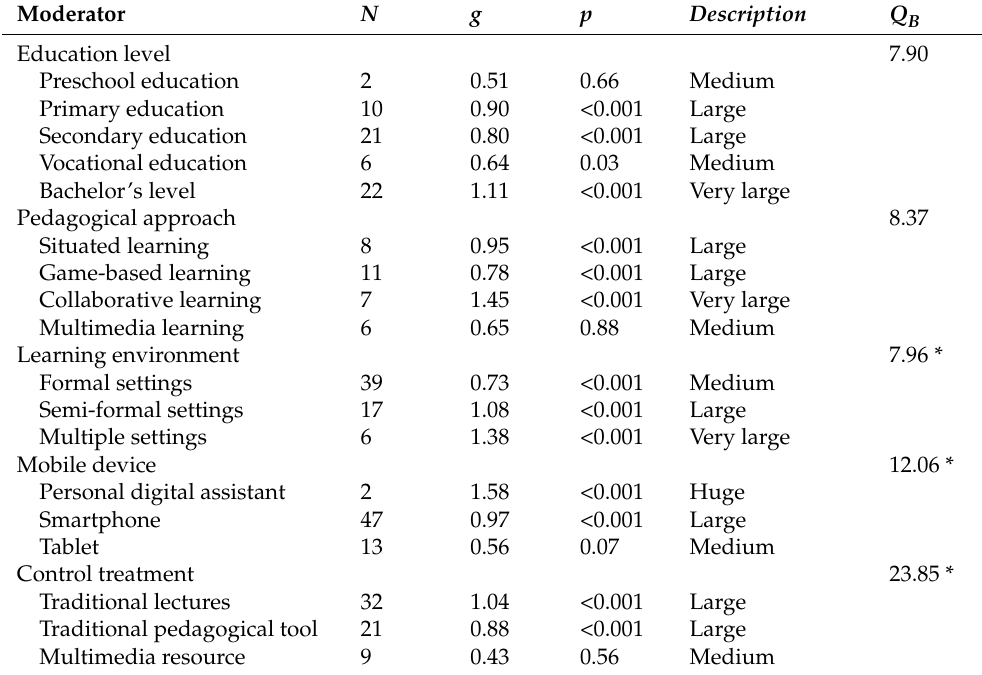
Table 1. Summary of the moderating analysis.